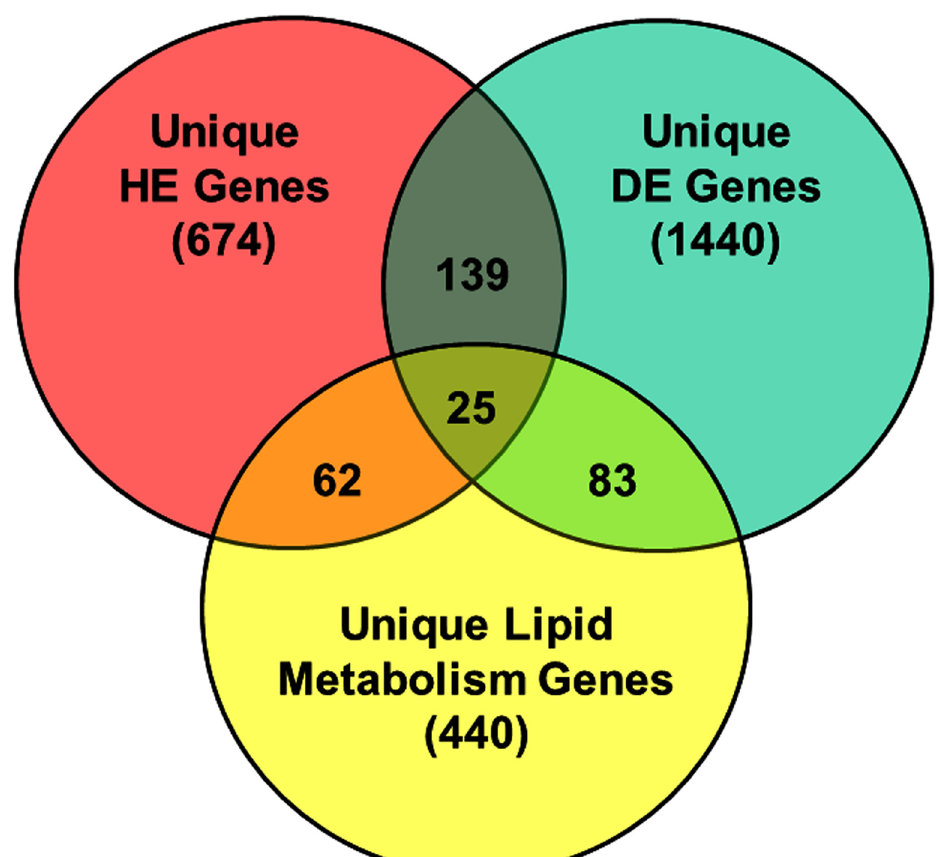
Fig 1. Venn diagram illustrating overlap among functional gene lists. The Venn diagram shows the intersections of highly expressed (HE) genes in abdominal fat (S3 Table), differentially expressed (DE) genes (S4 Table), and Ingenuity annotated genes known to be involved in lipid metabolism (S5 Table). The numbers in overlapping arcs indicate the number of genes shared between and among these three